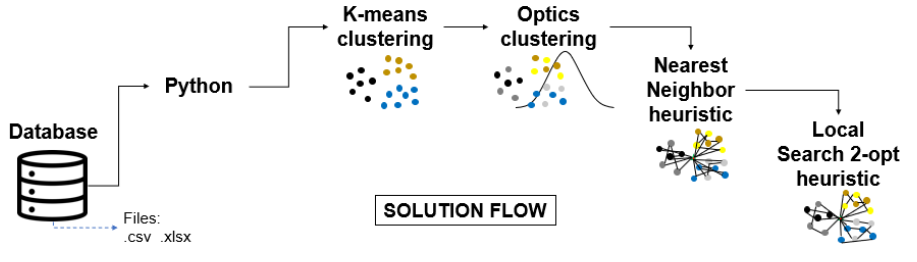
Fig. 4. Solution flow